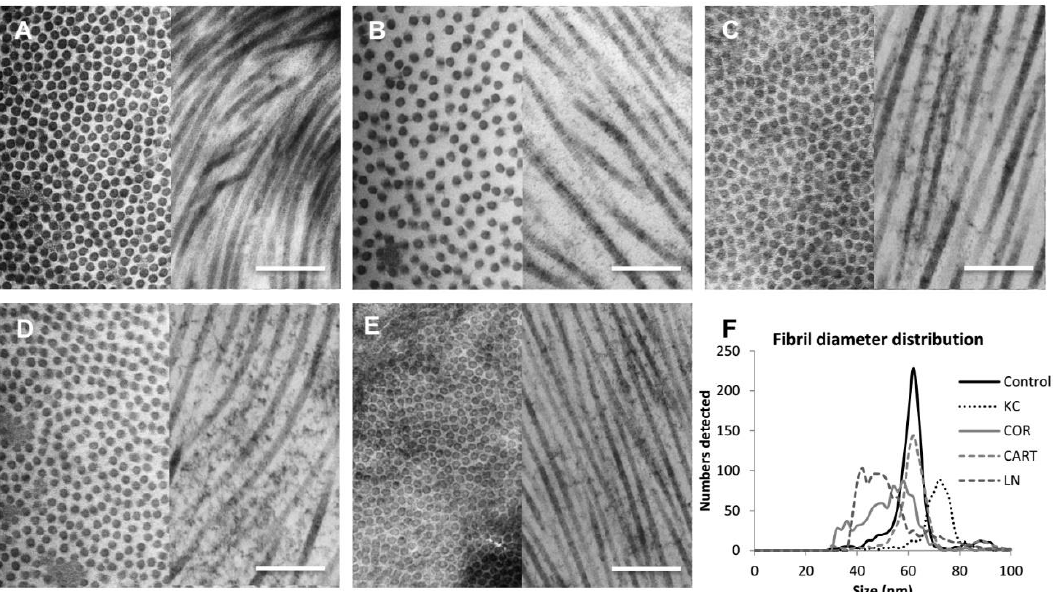
Figure 3. Characterization of corneal ultrastructure and fibril distribution. TEM images revealed ultrastructural changes of the corneas before and after treatments. ( A ) Control corneas ( B ) KC corneas presented thicker fibril diameters and lower fibril density as compared to the control corneas. ( C ) Corneal TDP treated corneas ( D ) Cartilage TDP treated corneas, ( E ) Lymph node TDP treated corneas, ( F ) Fibril diameter distribution among control, KC and three TDP groups. Scale bar = 1 µm.